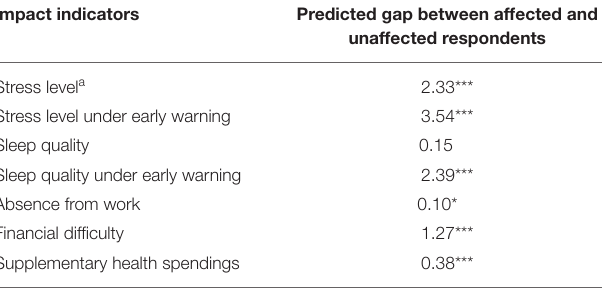
TABLE 4 | Indicators based on Blinder-Oaxaca decomposition